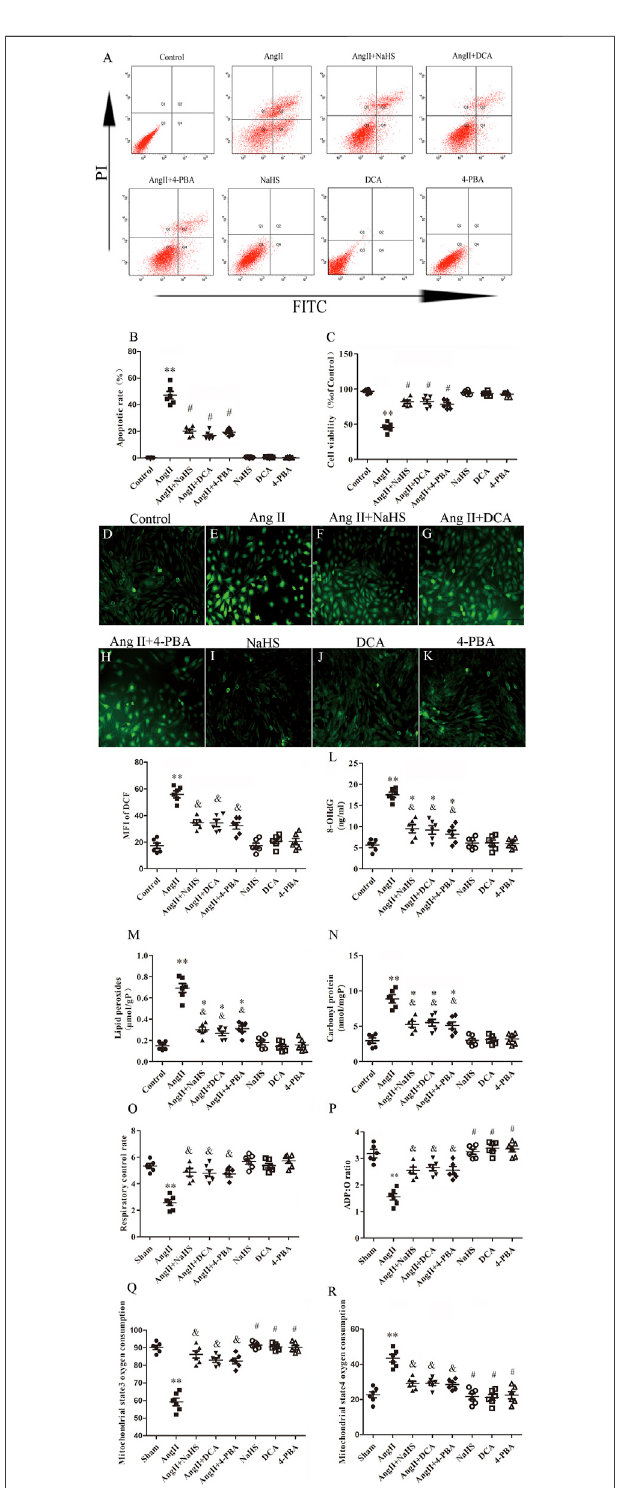
FIGURE6 | NaHS inhibits HL-1 oxidativestressinduced byAng II and is associated with attenuation of the Warburg effect and ERS. (A) Red staining with representative fl ow cytometry and quanti fi cation of the HL-1 cell apoptotic rate (B) were used as indication treatments ( n (cid:1) 6 in each